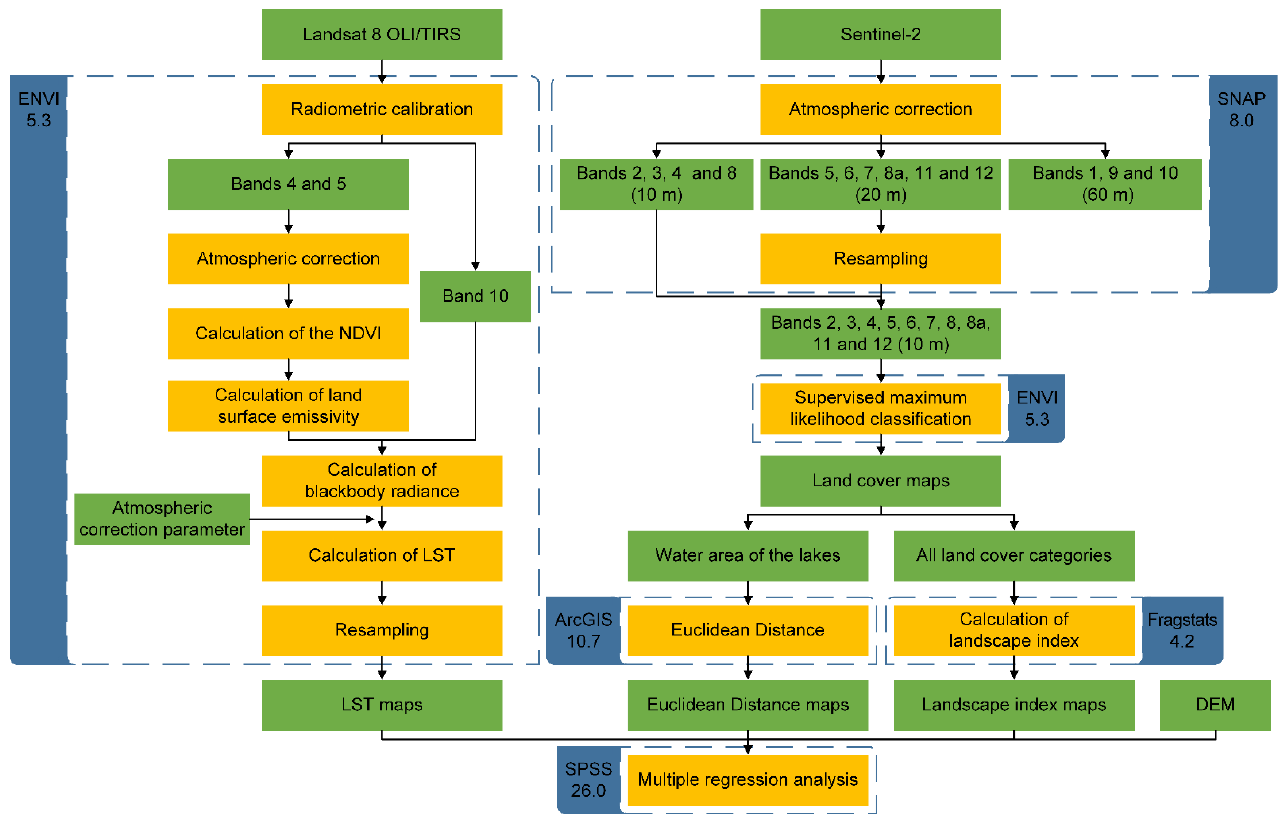
Figure 2. Overall workflow of this study. Green, yellow, and blue represent data, operations, and software, respectively.